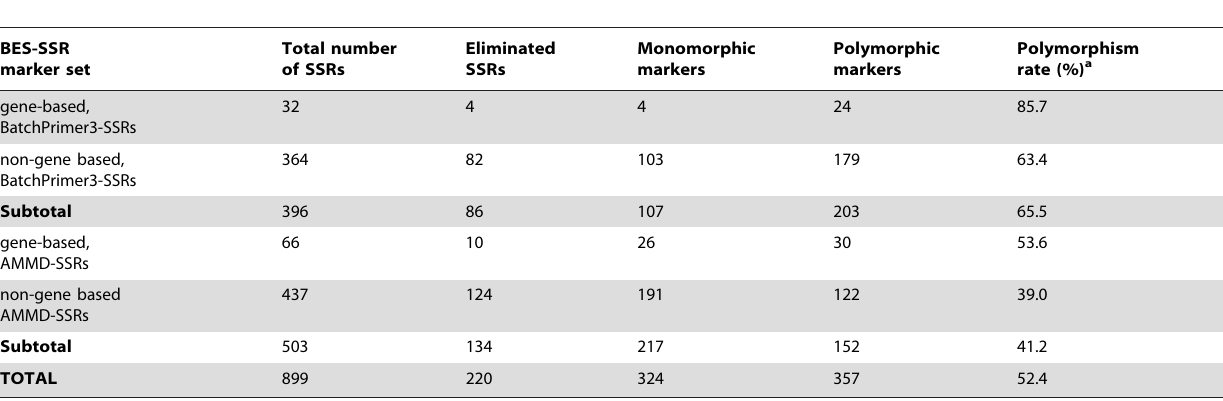
Table 1. Number of genic and non-genic BES-SSR markers from singleton BAC clones designed with BatchPrimer3 and AMMD that were monomorphic, polymorphic or eliminated due to amplification problems in the parental